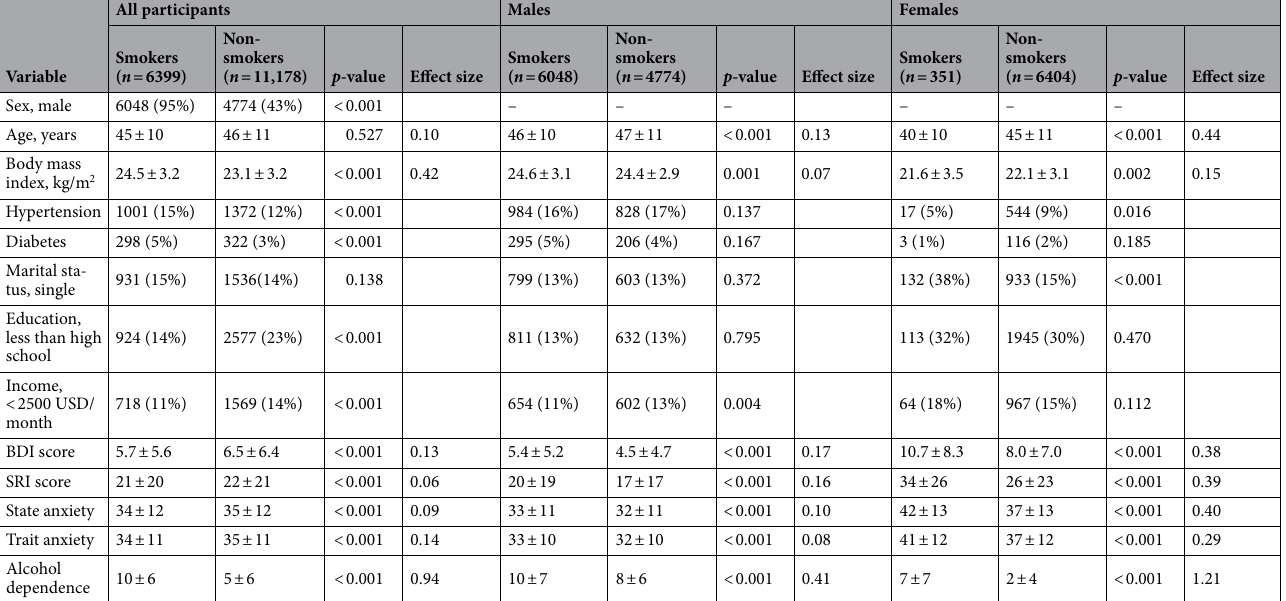
Table 1. Clinical characteristics and mental health status of the smokers and non-smokers. BDI Beck Depression Inventory, SRI Stress Response Inventory. Data are presented as the mean (standard deviation) or number